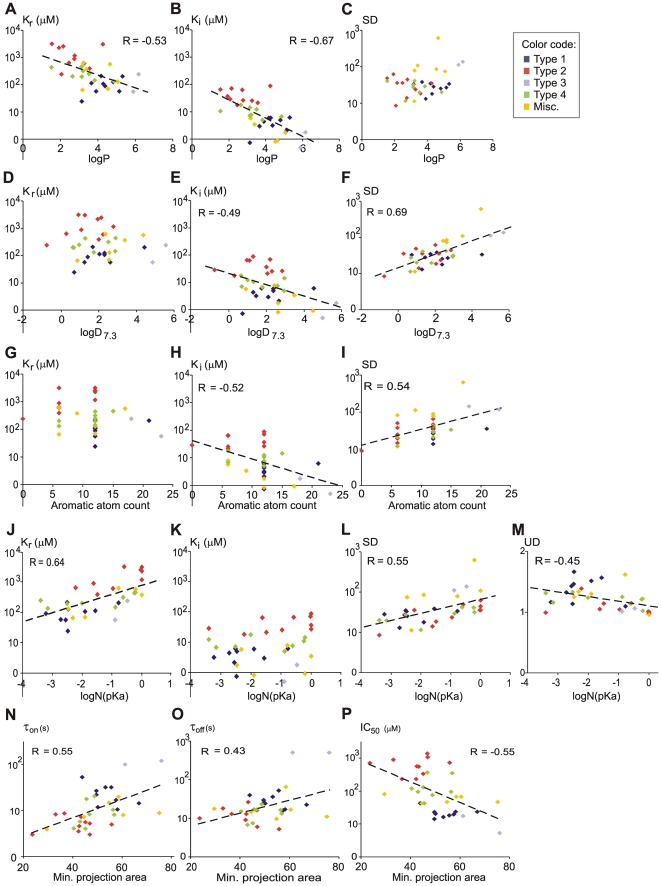
Dependence of properties of inhibition on specific chemical properties.Drugs belonging to different types of inhibition are shown in different colors. For values of individual drugs see Table 2, Table 3 and Results S6. Biophysical properties plotted against chemical descriptors. A)–C): logP, D)–F): logD7.3, G)–I): aromatic atom count, J)–M): logN(pKa), N)–P): minimal projection area. Regression lines and correlation coefficients (R) are only shown where the correlation was significant (p<0.01).